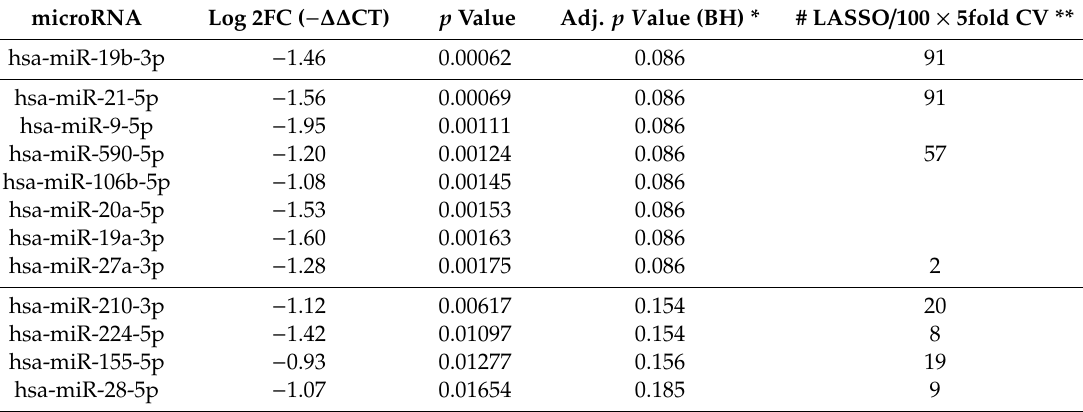
Table 2. Di ff erential expression of selected miRNAs based on significantly regulated miRNAs and / or miRNAs predictive for classification between responder (R) and non-responder (NR) group using logistic regression (Least Absolute Selection and Shrinkage Operator (LASSO) regularization and 100 × 5-fold cross